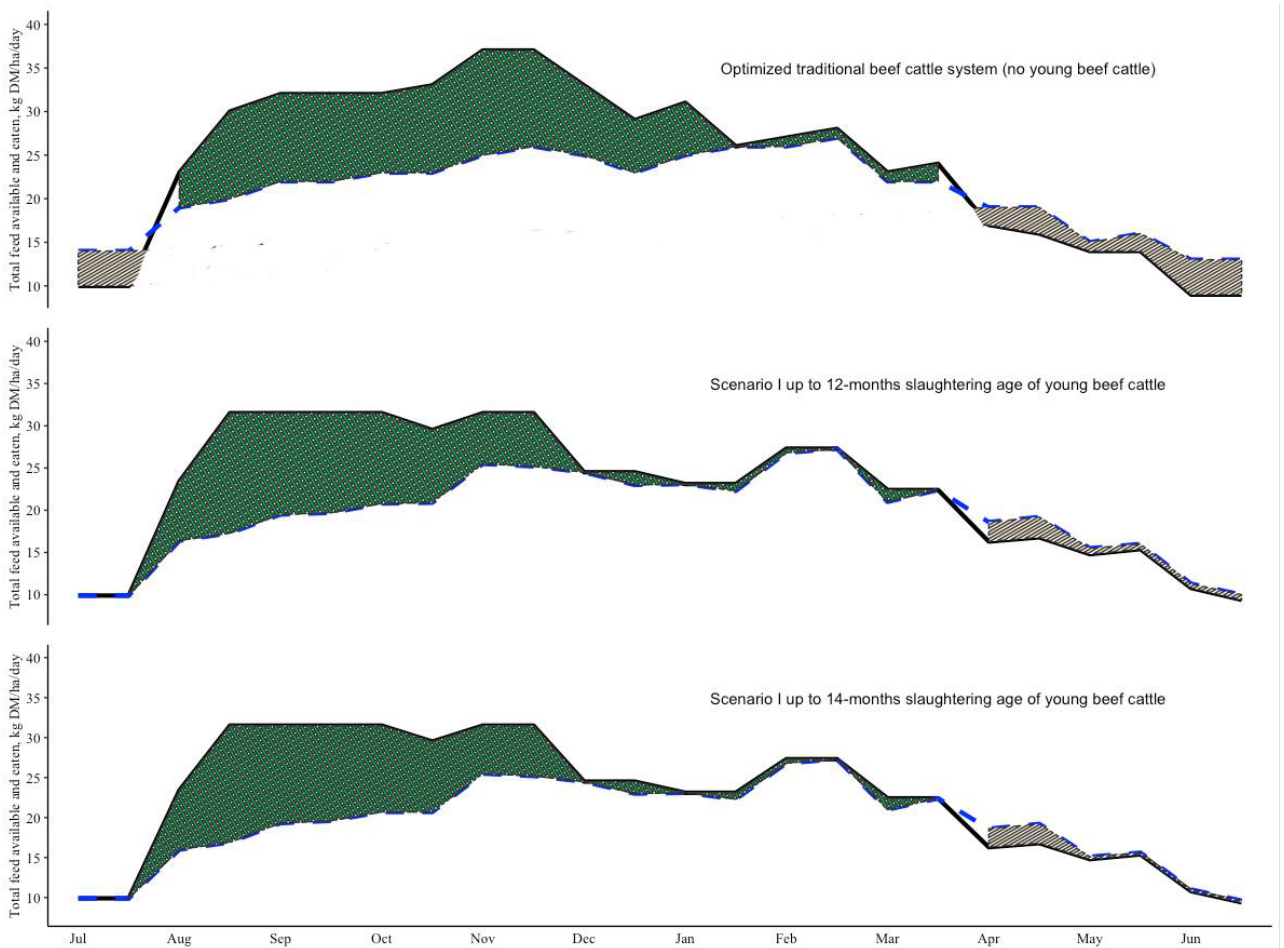
Figure 1. Utilizable pasture available (black line) and eaten by the beef cattle activity (blue dashed line which included silage) in the Optimized system and Scenario I throughout the year. The excess available herbage (i.e., neither utilized nor processed for silage) is indicated by the green shaded area and the deficient available herbage (i.e., where cattle requirements were greater than the available pasture) which was supplemented with silage as indicated by the striped area.